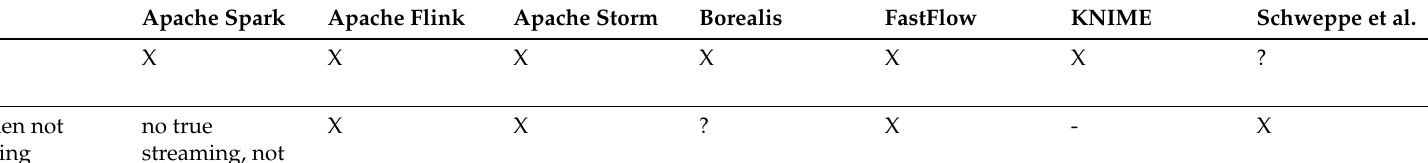
Table A3. Non-Functional